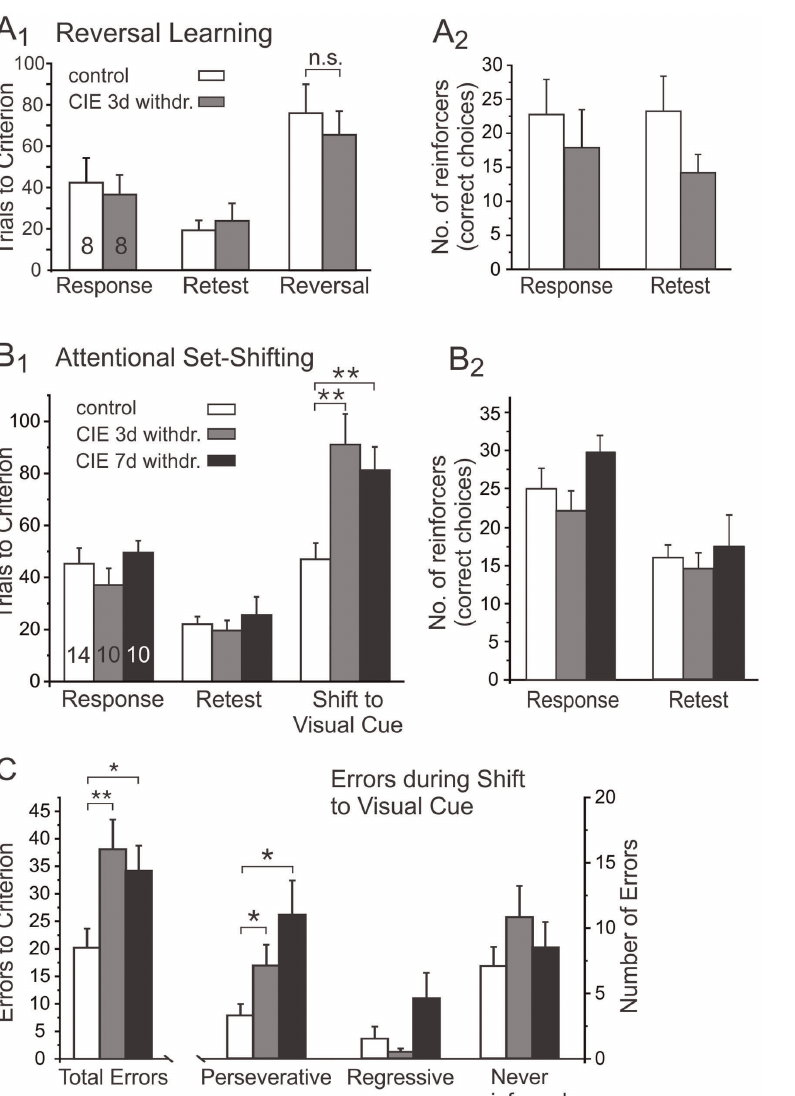
Figure 5. Chronic intermittent ethanol (CIE) exposure reduces the ability of mice to shift attention towards previously unrewarded stimuli in order to learn a new response strategy. A) CIE does not interfere with the ability to reverse a response discrimination in a T-maze. Mice were trained on a response discrimination (Response) that required them to always turn towards one side to obtain food reward. After 3 cycles of CIE or air exposure and 3 days of withdrawal, mice were retested (Retest) using the same turn discrimination. Animals in both groups showed a small improvement in performance on Retest day, indicating that CIE did not impair the retention of the previously learned strategy. On the following day, mice were required to reverse their strategy (Reversal) and turn towards the opposite arm to obtain the reward. The bar graph in A1 shows the total number of trials to criterion on the 3 test days for mice in the control (n=8) and CIE (n=8) groups. Data in A2 shows the number of reinforcers earned (i.e. the number of correct choices) during training (Response and Retest Day). No differences were observed between the treatment groups on any test day. B, C) Attentional Set-shifting is impaired in CIE exposed mice. Mice were trained on a response discrimination task as described in A with the addition of a visual cue (Response). After 3 cycles of CIE or air exposure and 3 or 7 days of withdrawal, mice were retested on the Response Discrimination (Retest). On the following day, mice were trained to shift attention to the visual cue to obtain food reward (Shift to Visual Cue). B1) CIE exposed mice required significantly more trials to reach performance criterion on Reversal Day. B2) Changes on Reversal Day were not due to differences in association strength established during training. The number of reinforcers earned (i.e. the number of correct choices) was not different in all treatment groups. C) Analysis of the types of errors committed on Reversal Day revealed that CIE exposed mice made significantly more perseverative errors than mice in the control group. Other types of errors did not differ significantly, indicating that once the new strategy was acquired, the mice had no difficulty in maintaining the new response strategy. All data are expressed as means 6 SEM. **p , 0.01 and *p , 0.05 significantly different from the vehicle control group (ANOVA and post-hoc analysis using unpaired Student’s t-tests). doi:10.1371/journal.pone.0037541.g005 spines have also been observed in response to exposure to Although our observations in acute slices demonstrate that CIE psychostimulants [46]. Thus, our data provide further evidence of exposure alters NMDAR function and NMDAR-dependent synaptic plasticity in the mPFC, it is not clear how these changes structural remodeling in response to alcohol and drug exposure. will affect neural networks in the mPFC. Based upon previous